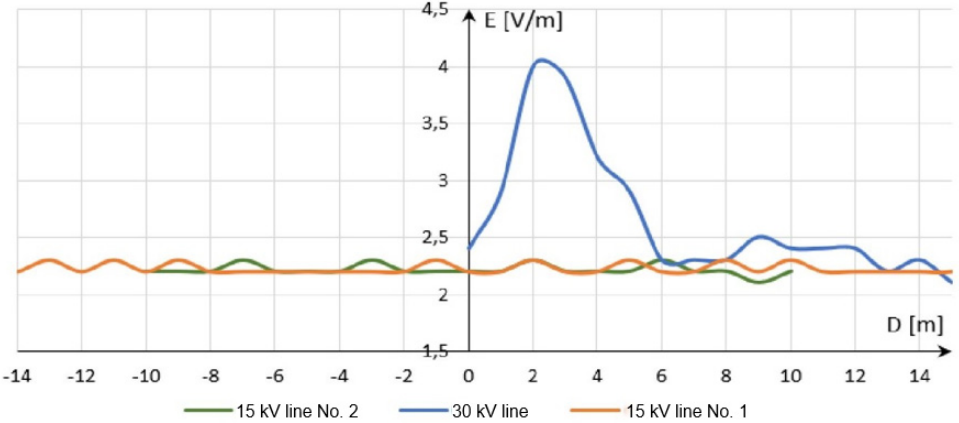
Figure 13. Distribution of electric field strength E across the line, for measuring point No. 2 and the VLF frequency range (induction measuring methodology as in Figure 2).